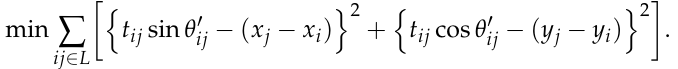
Figure S3: Relationship bewteen effective dis-tance based on diffusion and other distances, Figure S4: Residuals of the effective distance based on the diffusion process, Figure S5: Distribution of effective distance in different periods, Figure S6: Effective distance changes dynamically depending on stages of the pandemic, Figure S7: Local interactions with large passenger volumes, Figure S8: Distorted maps of Japan based on effective distance in different weight ratio between effective distance and local interactions, Figure S9: Putative map of Japan during the Tokyo 2020 Olympic used for the simulation in Figure 6b, Table S1: Parameters in the SEIR model and the estimated values, Table S2: Parameters in the diffusion equations, Table S3: Effective distance in each prefecture in the respective